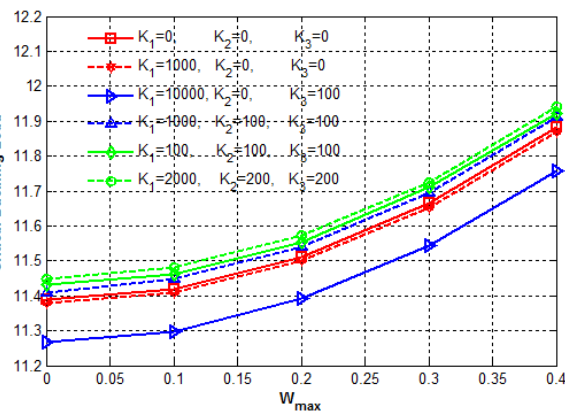
Figure 6: Effect of foundation parameters on critical buckling load